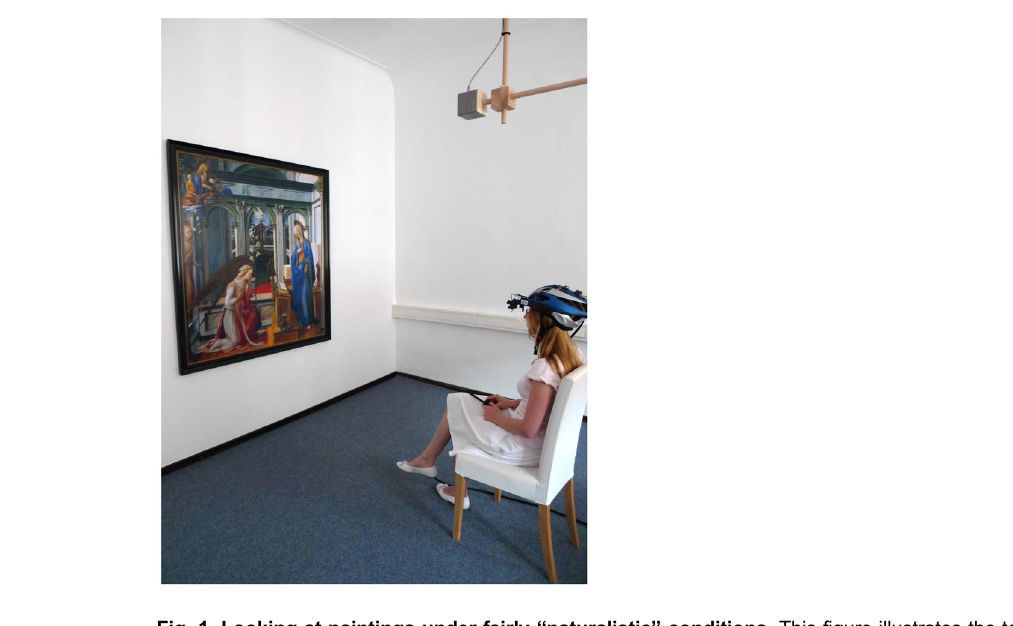
Fig. 1. Looking at paintings under fairly ‘‘naturalistic’’ conditions. This figure illustrates the testing conditions in the Heidelberg gaze movement lab. Participants were allowed sit on a chair or walked around within a circle with a radius of 1.2 meter to approximate viewing conditions in art